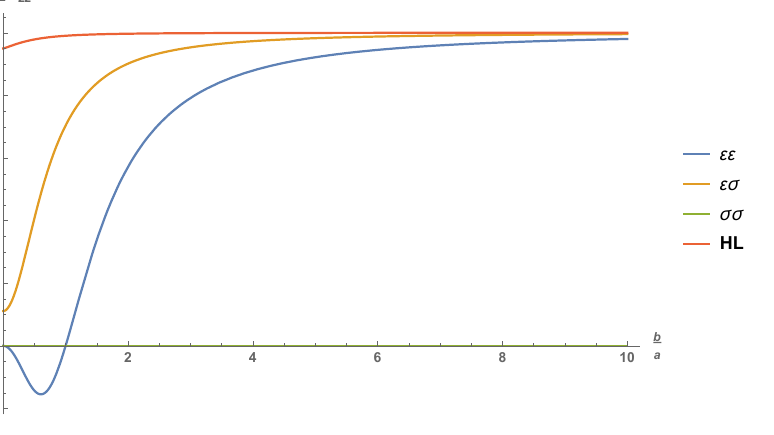
Figure 48 . Plots of the ratio (6.53). We used h